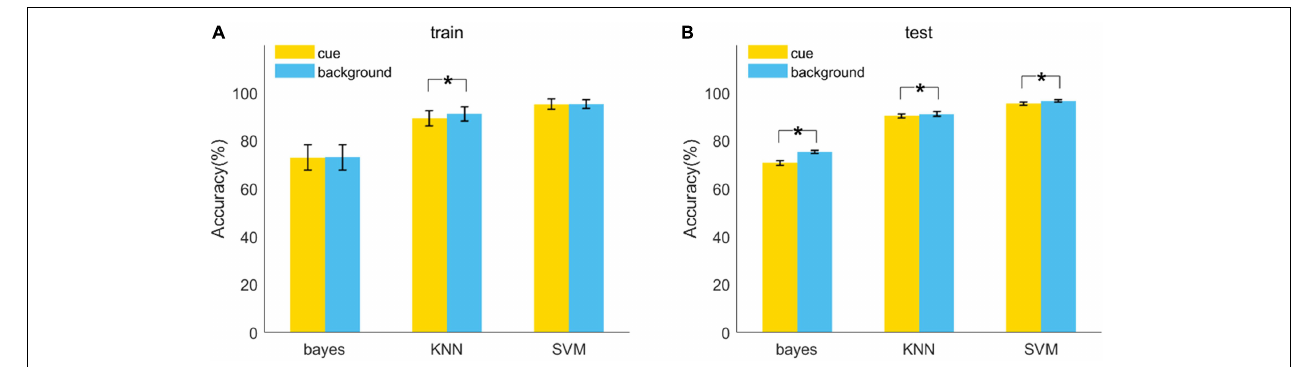
FIGURE 2 | Model accuracy of the classification of FR and noFR in 10-fold CV train (A) and test (B) repeated 15 times. Results were obtained by three kinds of models (Naive Bayes, KNN, SVM) based on all the features of six frequency bands in each condition (cue, background). The error bars are standard deviations. * p < 0.01.